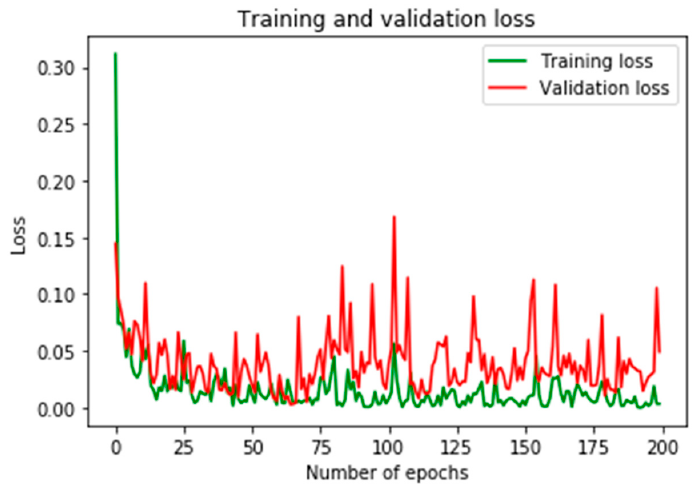
Figure 12 . Showing training and validation accuracies using ResNet152 .